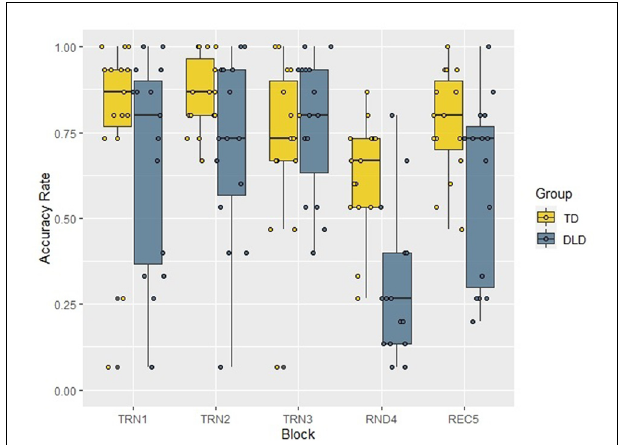
FIGURE 4 | Accuracy rates by Block and Group in the acoustic verbal target detection task. TD, typically developing children; DLD, children with Developmental language disorder; TRN1, First training block; TRN2, Second training block; TRN3, Third training block; RND4, Random block with disrupted structure; REC5, Recovery block.